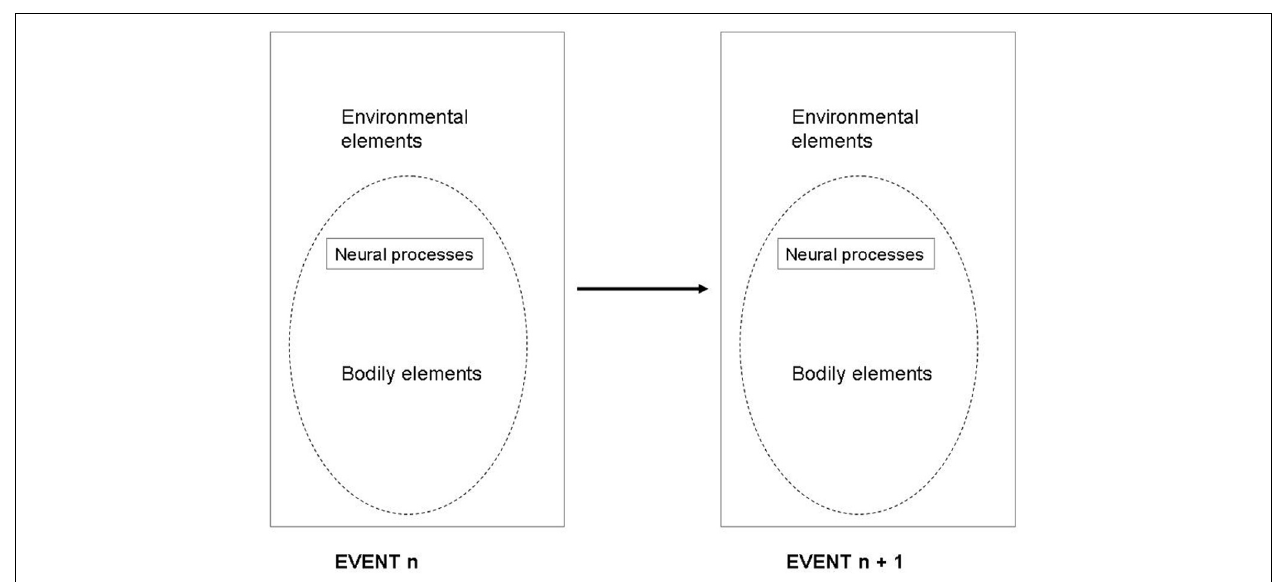
FIGURE 2 |The framework characterizing event n mapping onto event n + 1 .